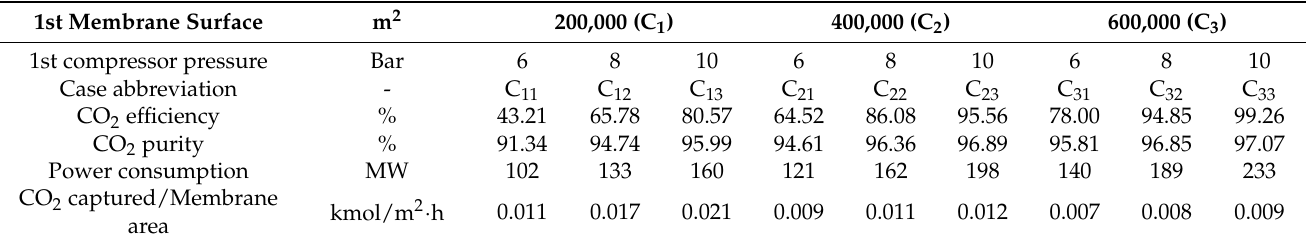
Table 15. The specific parameters were chosen for the technical and economical assessment of 2-stages of membrane technology, case